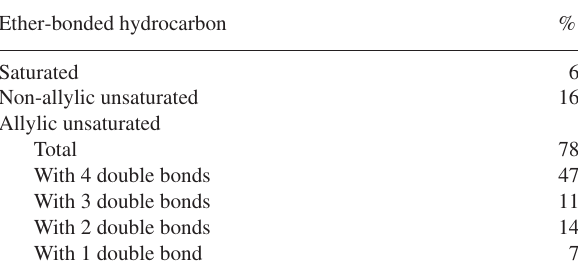
tively analyzed by GLC with n -tetracosane (C 24 ) as an internal stan- dard.